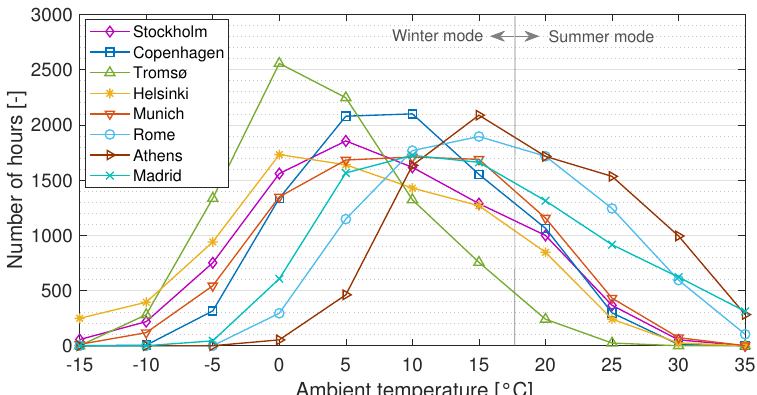
Figure 6. Number of hours per year at different ambient temperatures for the selected locations.